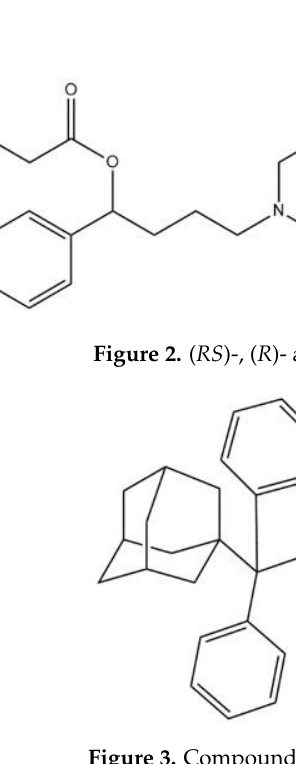
Figure 3. Compound 1 and its IC 50 values for σ receptors and Na + channels.